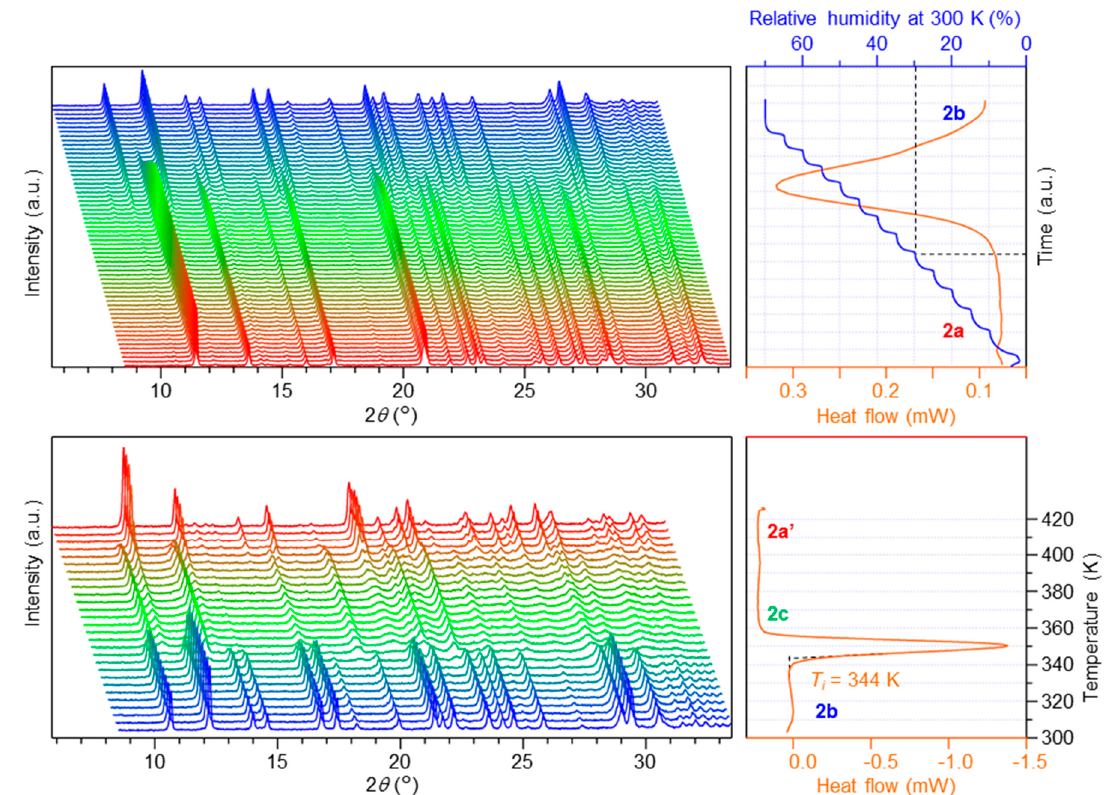
Figure 2. Results of XRD-DSC measurement: ( a ) during humidifying 2a (upper), ( b ) during heating 2b (lower).